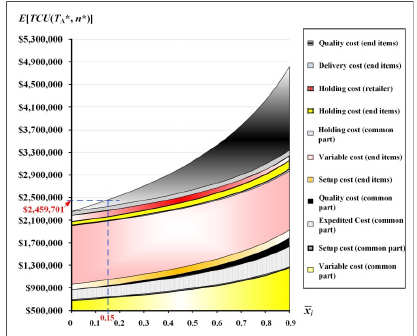
Fig. 8. The mean scrap rate x i effect on different cost contributors of E [ TCU ( T A *, n